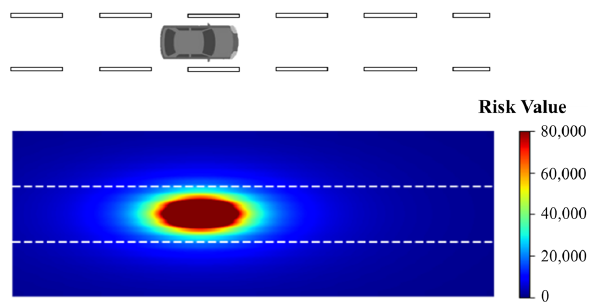
Figure 4. A sample distribution of obstacle risk field.